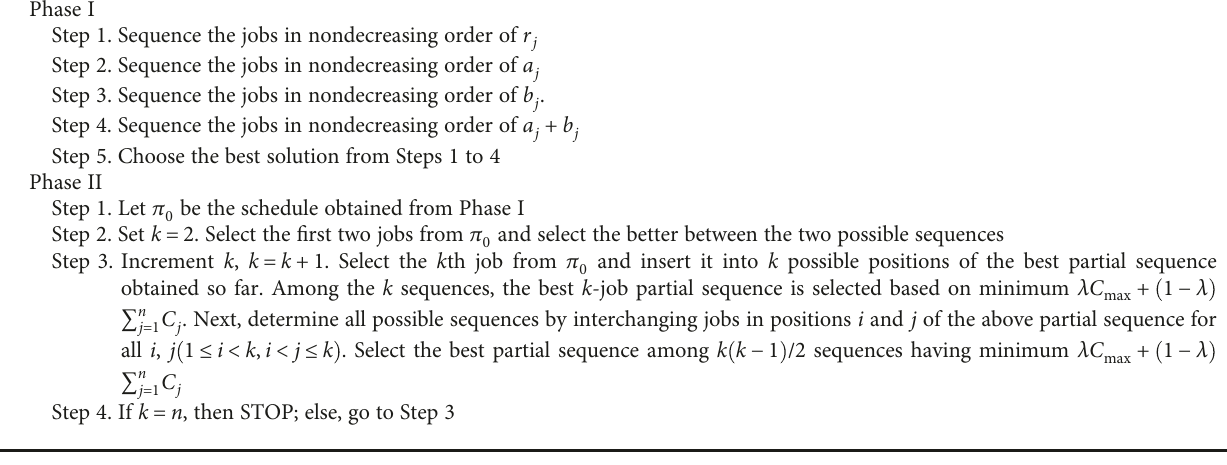
Table 1: Results of the B&B algorithm and the FLTPA heuristic for r